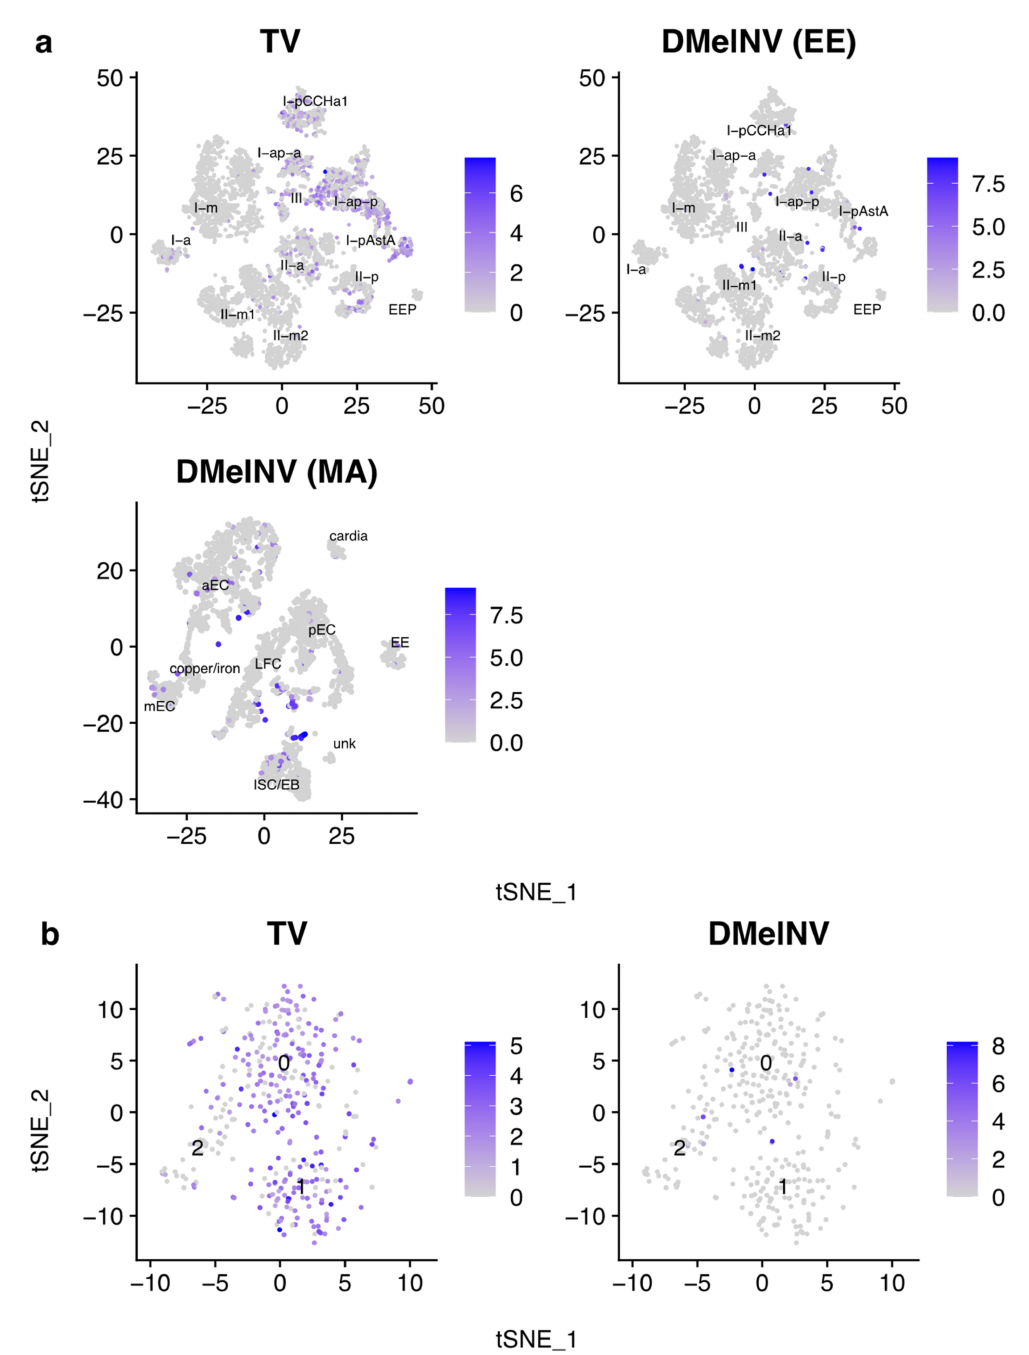
Figure 8. Confounding effects of viral infection on cell clustering and cell type annotation. t-SNE reduction plots of the ( a ) EE and MA datasets and ( b ) I-p AstA EE subtype. Each point represents a single cell. The log(pseudocount + 1)-transformed proportion of viral counts (multiplied by a factor of 10,000) is shown for each